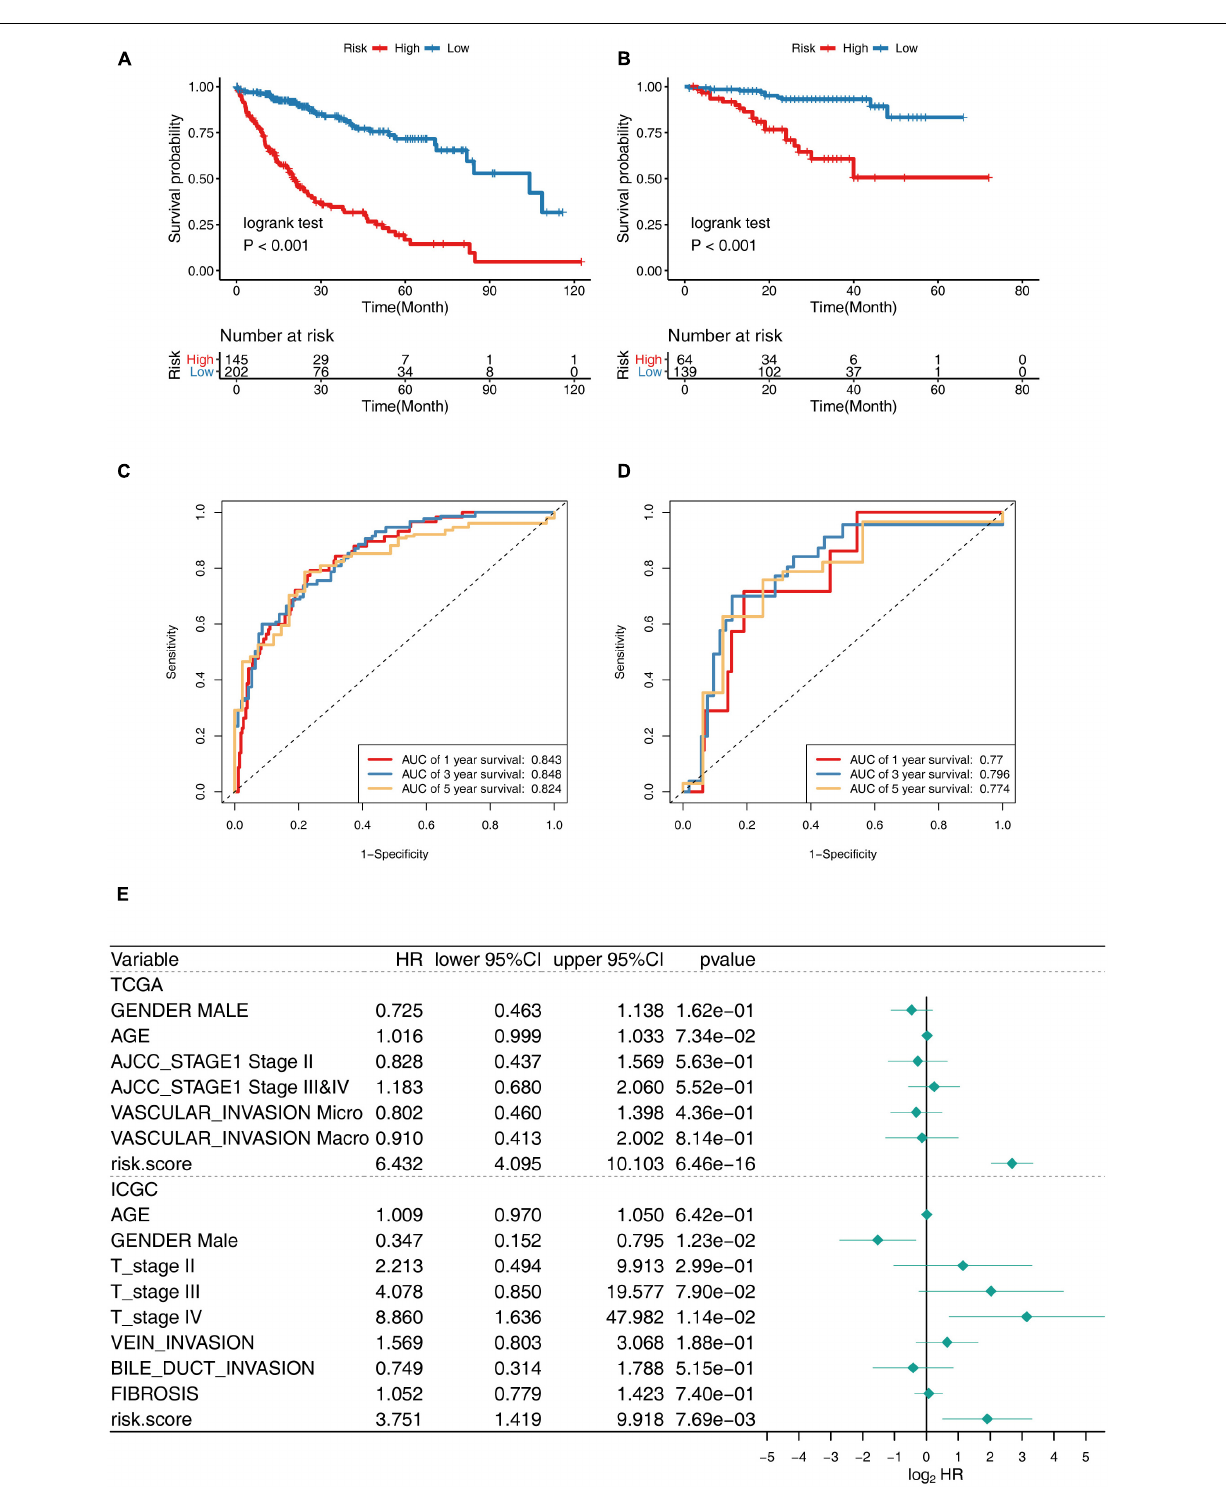
Frontiers in Cell and Developmental Biology |